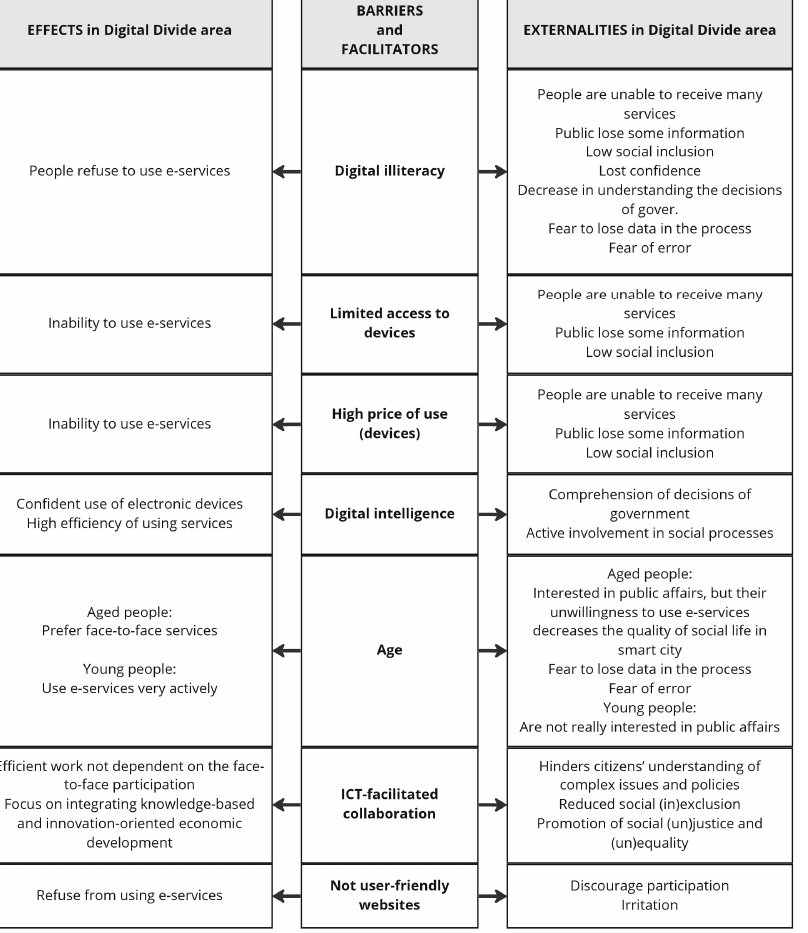
Figure 7. Barriers or facilitators, effects, and externalities of smart governance implementation in the Digital Divide area. Source: generated by the authors.